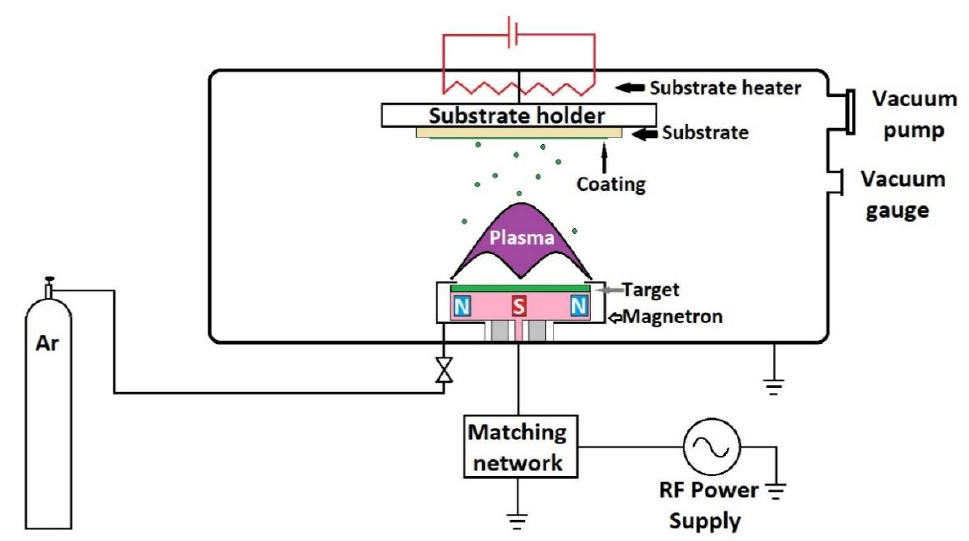
Figure 4. Schematic representation of radio frequency magnetron sputtering unit.